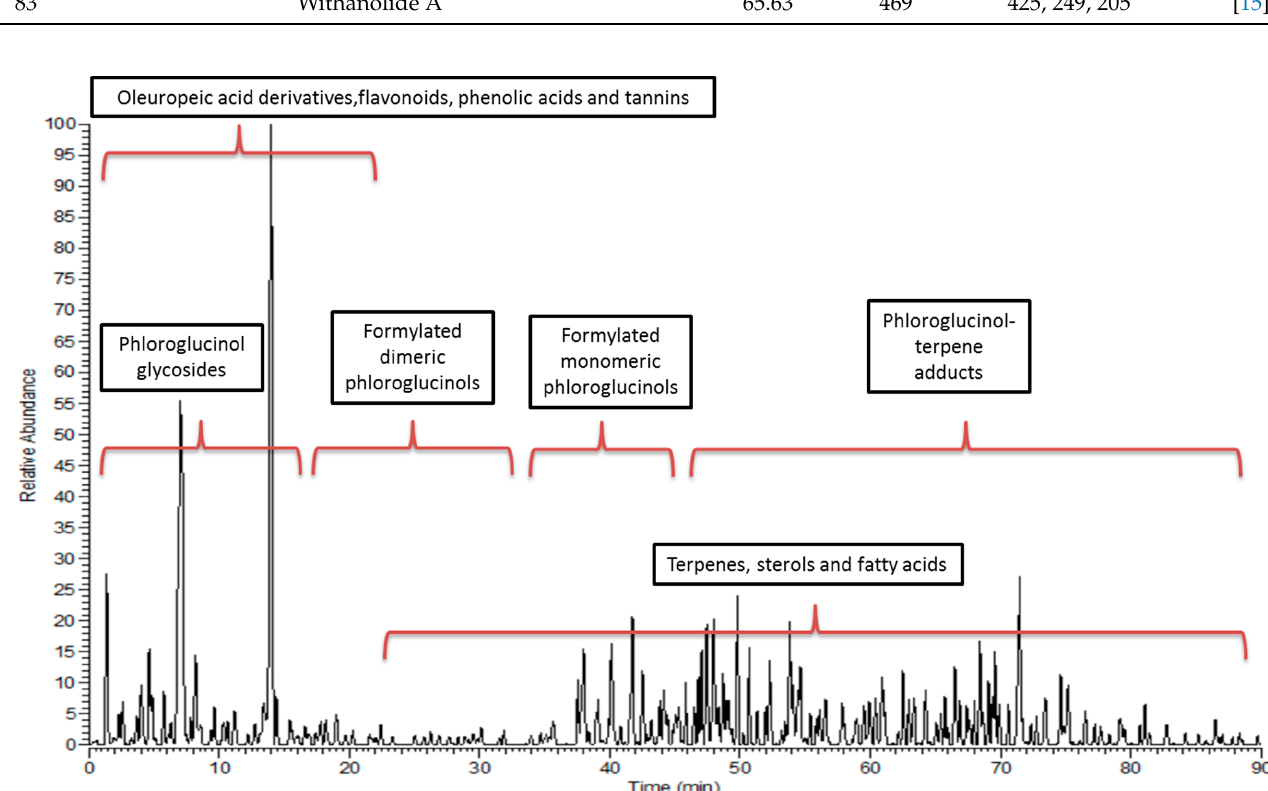
Figure 3. LC-MS/MS profile of the methanolic extract of E. sideroxylon flowers.